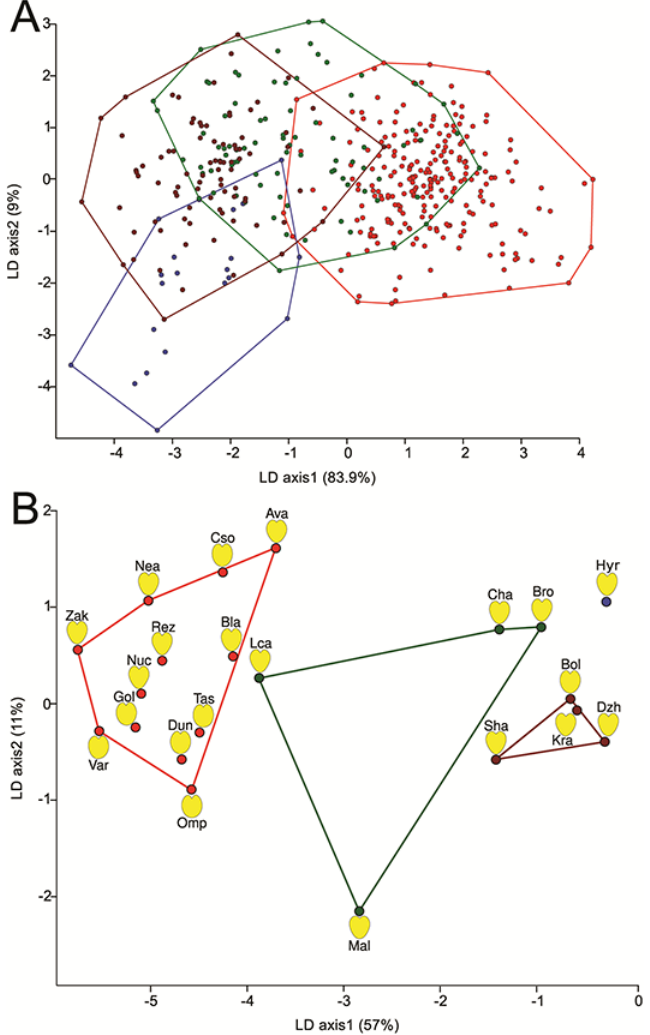
Figure 4 Scatterplots of grouped geographical regions revealed by linear discriminant analysis (LDA) implemented in PAST ( A ) and population group centroids identified by LDA ( B ) with convex hulls drawn based on the geographical regions of origin. Color codes correspond to geographical regions as follows: brown – Caucasian region; red – Carpathian region; green – Western Europe; blue – Hyrcanian region. Calculated population mean shapes are depicted next to the group centroids. Please refer to Table S2 for descriptions of the identification